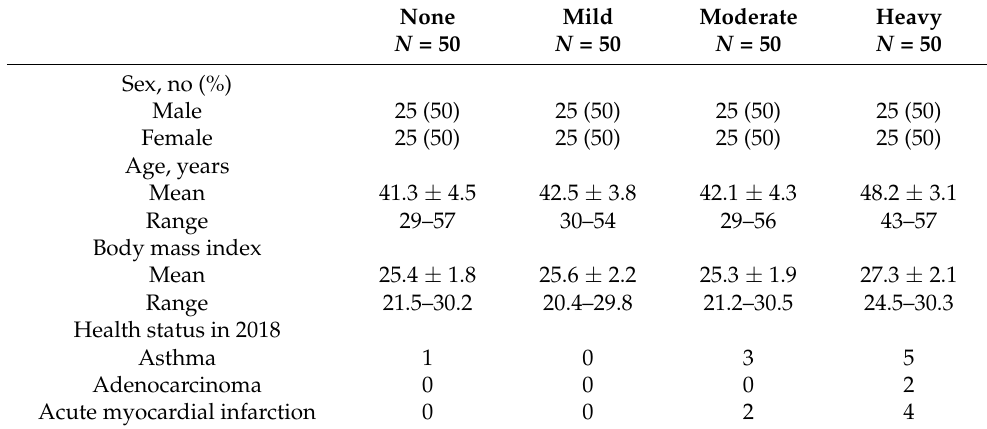
Table 1. Basic characteristics of the 200 participants grouped by essential oil usage.